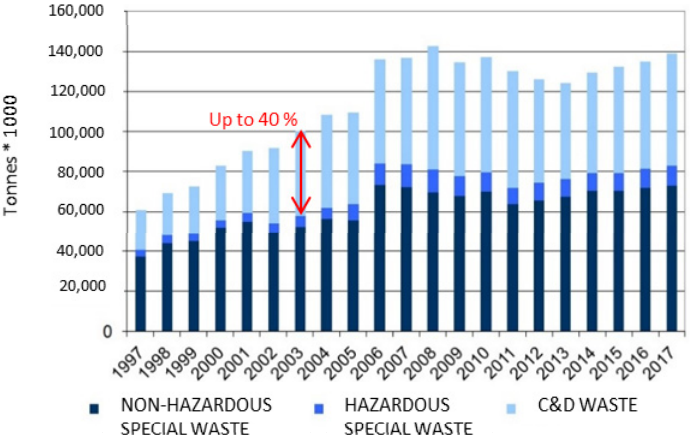
Figure 2. Special waste production in Italy. Source: Own elaboration from ISPRA data.